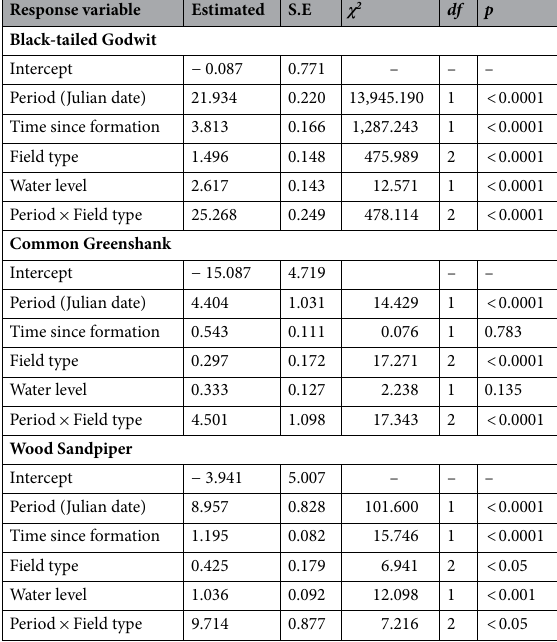
Table 2. Results of the generalized linear mixed model examining the impact of field type and time since habitat formation on the abundance and distribution of shorebird species visiting the paddies. The sample sizes of black-tailded godwits, common greenshanks, and wood sandpipers were 809, 250, and 465, respectively. Each species was analyzed using density (individuals/paddy) as the response variable, field type (plowed, harrowed, or seeded) and time since habitat formation as the explanatory variables, and survey time and individual paddy as stochastic variables. SE = standard error.